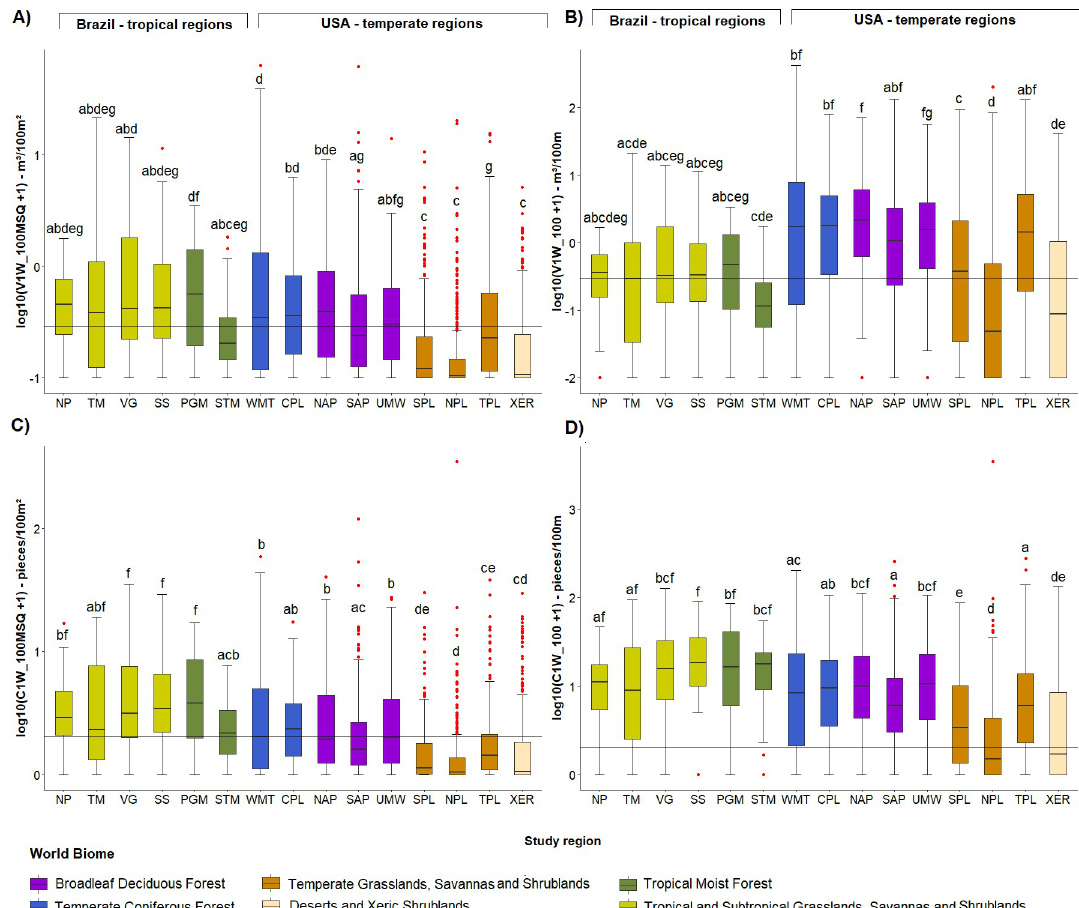
Fig 9. Boxplots of the instream wood quantities in logarithmic scale for Brazil and USA regions. The large wood (LW) volume per 100 m 2 (V1W_100MSQ) in (A), the LW volume per 100 m (V1W_100) in (B), the LW pieces per 100 m 2 (C1W_100MSQ) in (C) and the LW pieces per 100 m (C1W_100) in (D). The line crossing the chart represents the mean for all regions. In the boxplots the line represents the median, the box is the first (25%) and the third (75%) quartiles, the whiskers extend to the most extreme data point which is no more than 1.5 times the length of the box away from the box, the red dots are the outliers defined by the ‘1.5 rule’. The colours in the boxes indicate the biome where each region is located. Different letters next to whiskers indicate which groups differed in post–hoc comparisons (Tukey’s